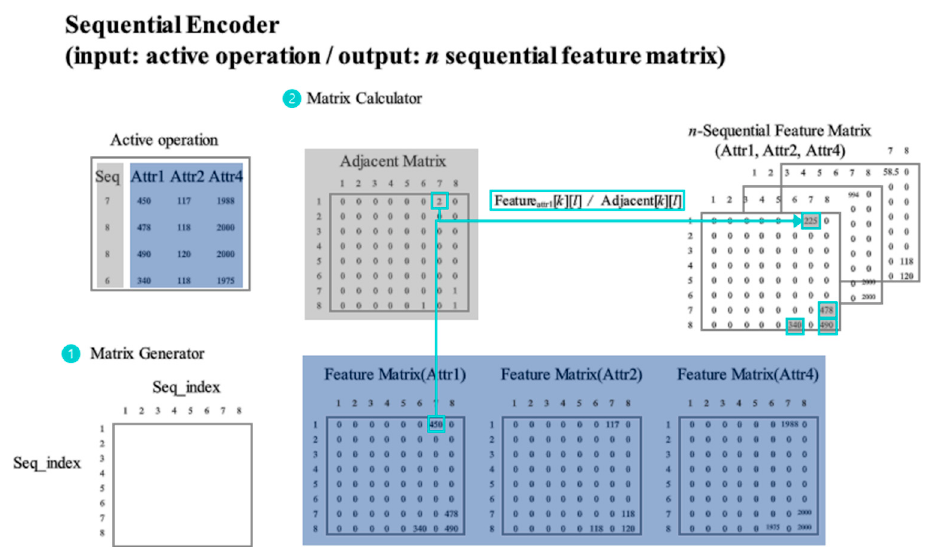
Figure 7. Sequential encoder and I/O.